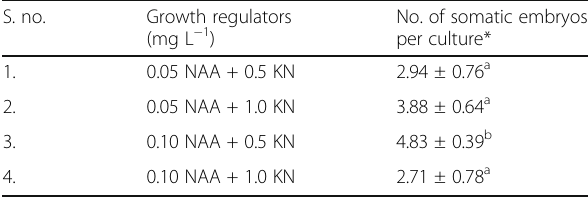
Values represent mean ± SE *Fifteen replicates per treatment, repeated thrice One-way ANOVA with Duncan ’ s multiple range test was applied Data in columns followed by different letter (superscript) significantly different at 0.05 %